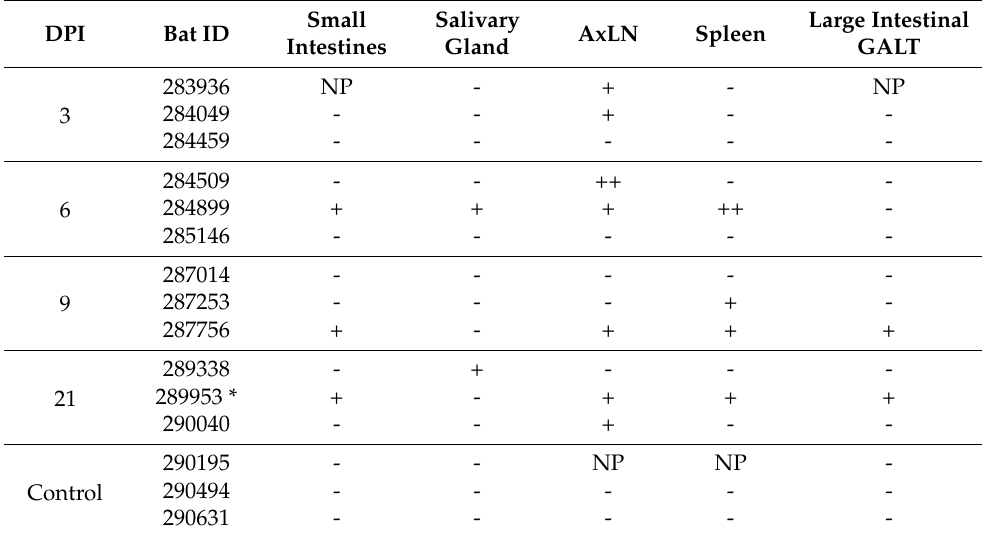
Table 1. Distribution of Sosuga virus nucleoprotein antigen in selected tissues from SOSV-infected Egyptian rousette bats euthanized at 3, 6, 9 and 21